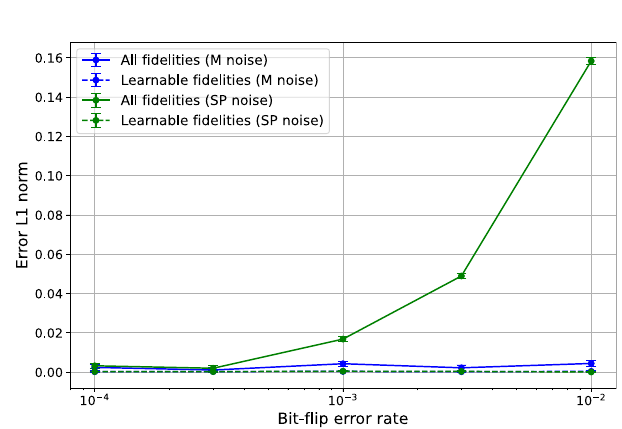
Fig. 5 | Simulation of intercept CB on CNOT under different SPAM noise rate. Thesimulatednoisechannelisa2-qubitamplitudedampingchannelwitheffective noise rate 5%, and SPAM noise are modeled as bit- fl ip errors. For the blue (green) lines, we introduce random bit- fl ip errors to the measurement (state preparation). The solid lines show the l 1 -distance of the estimated Pauli fi delities from the true Pauli fi delities. The solid lines show the l 1 -distance of the (individually) learnable Pauli fi delities from the ground truth.